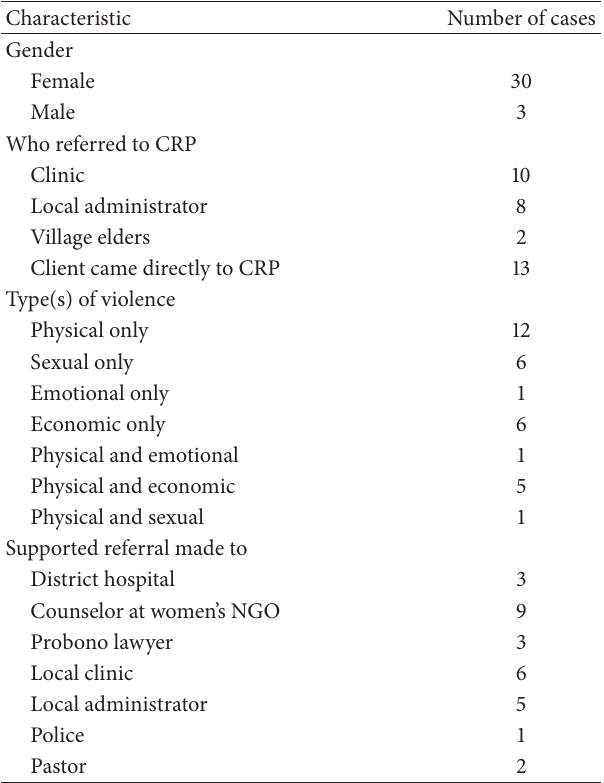
Table 2: GBV cases handled by community referral persons ( 𝑛 = 33